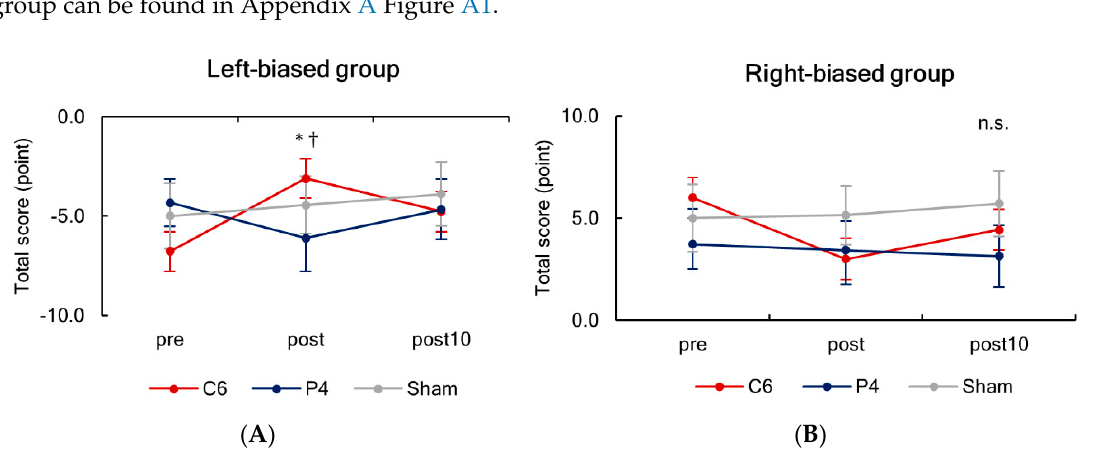
Figure 5. Serial changes in the total scores of line length judgement task before (pre), immediately after (post), and 10 min (post 10) after tSMS for 20 min, separately presented for the left-biased group ( A ) and right-biased group ( B ). In the left-biased group, the magnitude of bias was significantly reduced immediately after tSMS over C6, and the bias was significantly smaller for C6 as compared to P4 at post. * p < 0.001 vs. pre, † p < 0.05 vs. tSMS over P4.